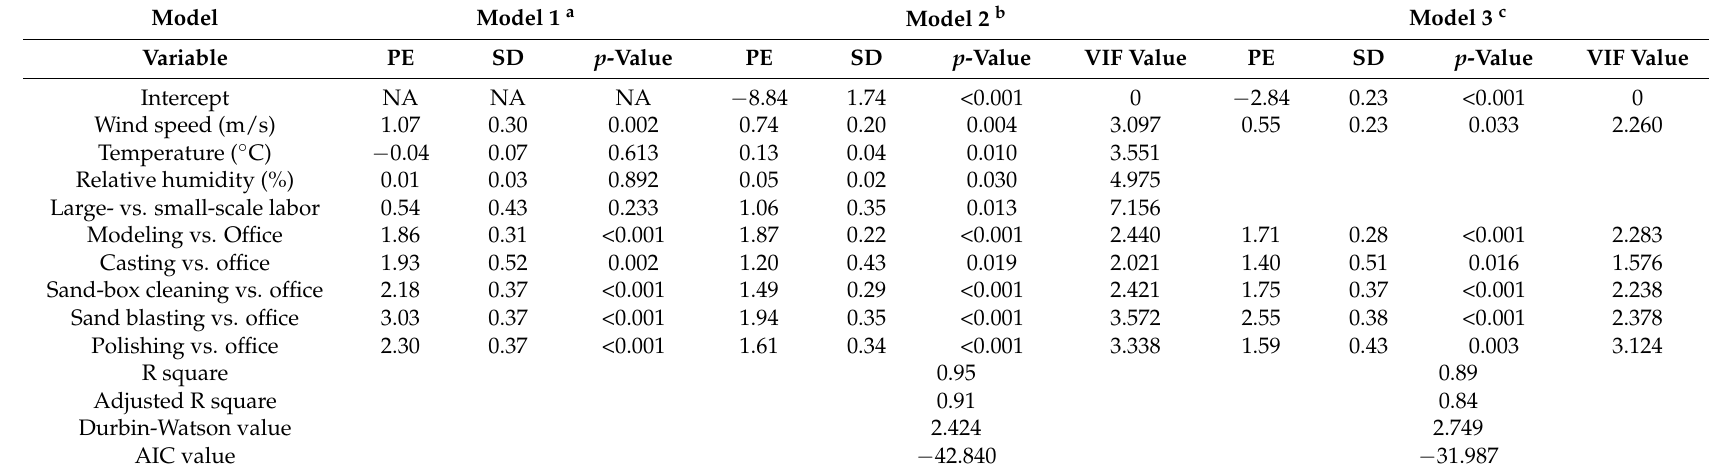
Table 4. Associations between climatic factors, labor scales, production areas, and levels of respirable crystalline silica ( n = 20).